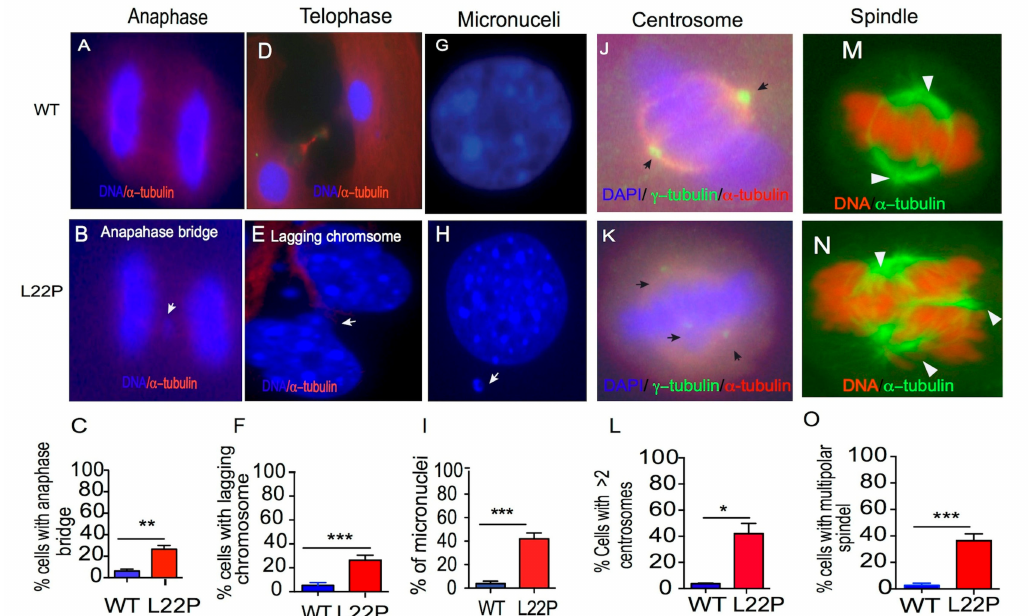
Figure 5. L22P cells exhibit mitotic defects. ( A , B ) Representative images of wild type (WT) and L22P cells with the anaphase bridge chromosomal segregation pattern; ( C ) Percent of cells with an anaphase bridge for WT ( n = 62) and L22P ( n = 57) cells; ( D , E ) Image of the lagging chromosomal structure in WT and L22P cells; ( F ) Percent of cells with lagging chromosomes at telophase for WT ( n = 110) and L22P ( n = 110) cells; the white arrow indicates lagging chromosomes; ( G , H ) Image of 4 (cid:48) ,6-diamidino-2-phenylindole (DAPI)-stained nuclei from WT and micronuclei in L22P cells in H indicated with white arrow; ( I ) Percent of micronucleus-positive cells for L22P ( n = 210) versus WT cells ( n = 214). ( J , K ) Image of centrosomes stained for γ -tubulin and microtubules stained with α -tubulin antibody; the black arrow indicates the centrosomes; ( L ) Percent of cells with greater than two centrosomes for L22P ( n = 168) versus WT ( n = 120) cells; ( M , N ) Image of the assembly of cell poles stained for α -tubulin; the white arrow indicates two poles in WT versus the multiple assembly of tubulin in L22P cells; ( O ) Percent of cells with multipolar spindles > 2 for WT ( n = 109) and L22P ( n = 87). All statistical analyses were performed with Student’s t -test and significance is represented by * p < 0.05; ** p < 0.01; *** p < 0.001 using GraphPad Prism (Prism 7.00 for Mac, GraphPad Software,